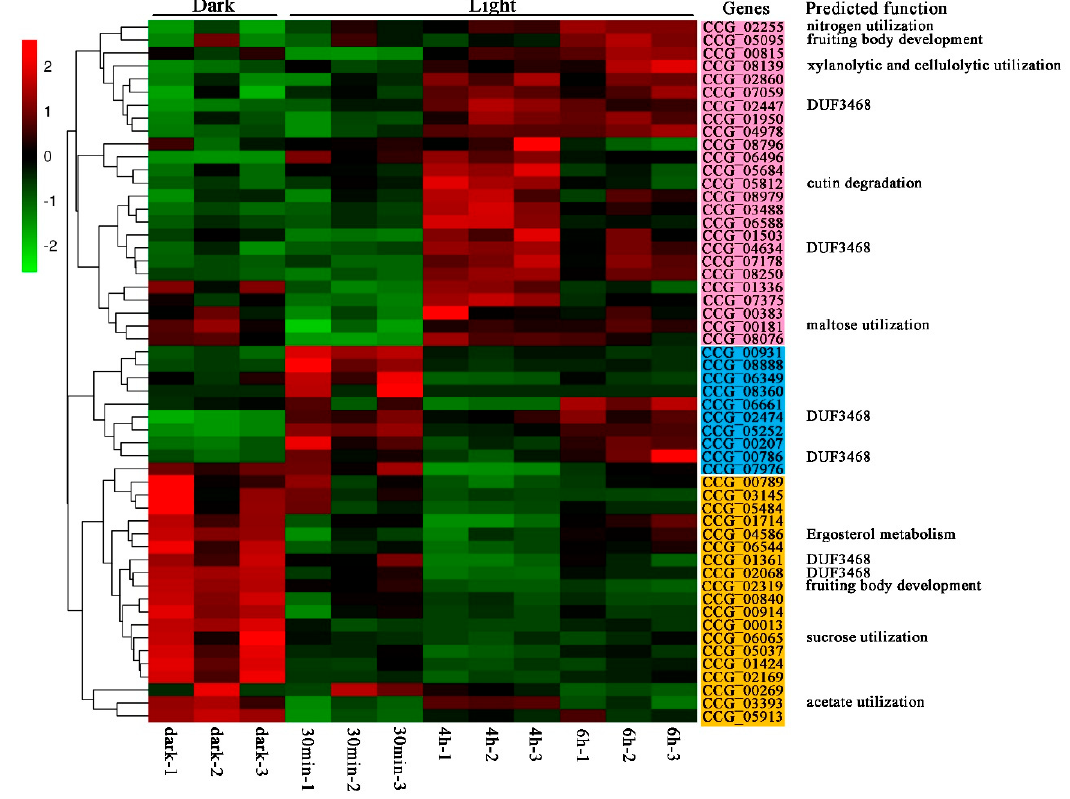
Figure 7. Expression levels of C6 zinc domain genes under different light conditions in T. guangdongense . The heatmap was constructed based on the FPKM values of C6 zinc domain genes. Genes immediately up-regulated by light are represented in pink, and immediately down-regulated by light are represented in yellow. Genes up-regulated by light after treatment for more than four hours are represented in